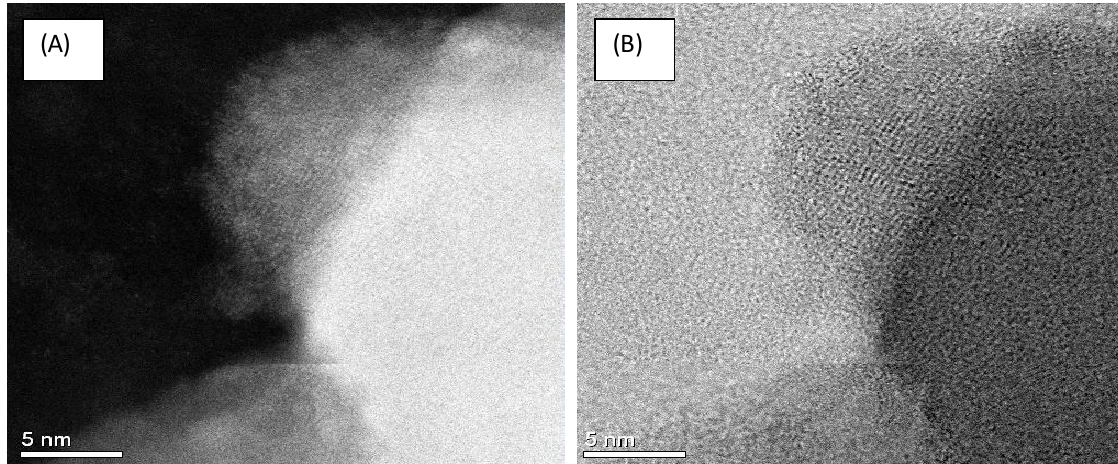
Figure 6. ( A ) Dark field and ( B ) Bright field STEM image of LiNbO 3 without the heat treatment reduction at 650 °C; one can observe the formation of spherical shaped nanoparticles; one can also observe the formation of the spherical shape as being caused by the e-beam after 10 min of observation at 200